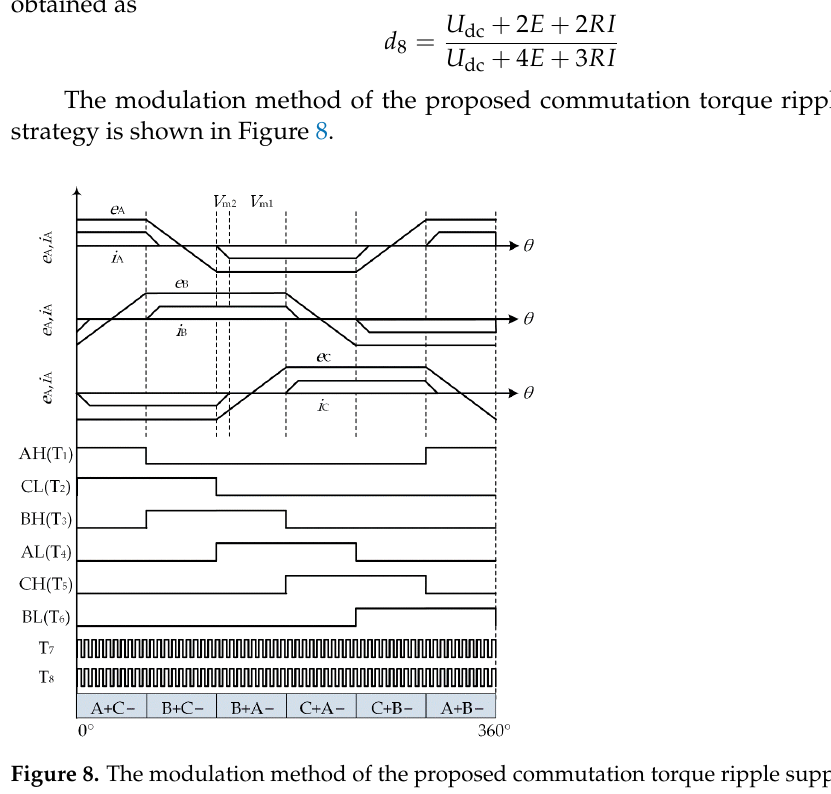
Figure 9. The experimental system. Table 1. The parameters of the motor. Parameter